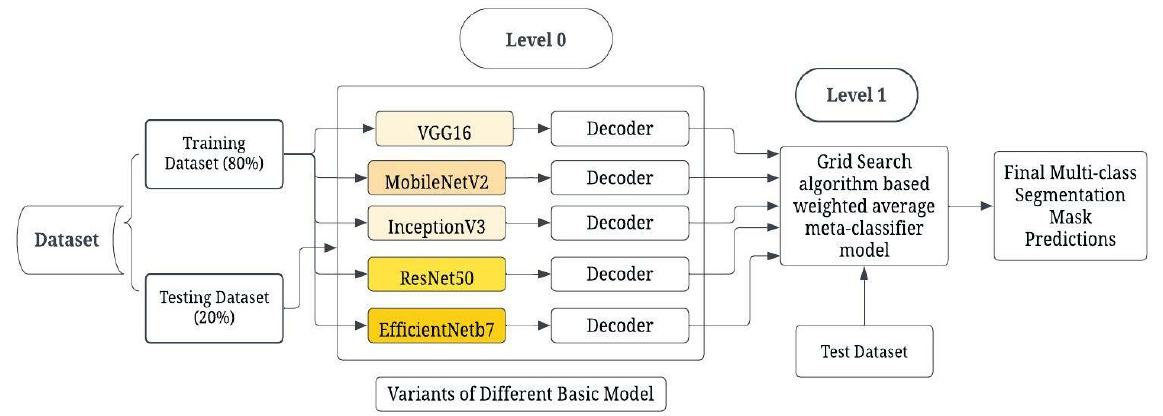
Figure 3. Overview of the framework for stacking-based ensemble approach of Segmentation Models.